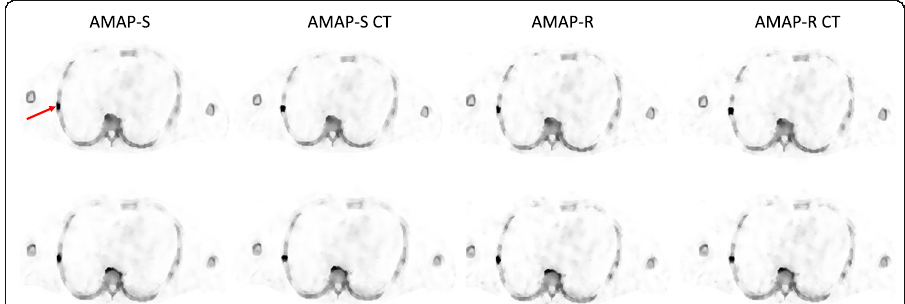
Fig. 4 Example reconstructed SPECT transverse slice for AMAP-S and AMAP-R with and without the 5-mm SPECT/CT mismatch at the level of rib lesion of the male patient study with artificial lesions. Red arrow shows the lesion location. AMAP-S and AMAP-R refer to reconstructions, where lesion is absent in the CT, AMAP-S CT, and AMAP-R CT to lesion-present cases. Top row shows aligned cases and bottom row reconstructions with the 5-mm SPECT/CT mismatch. The color scale is set to SUV 15 for all